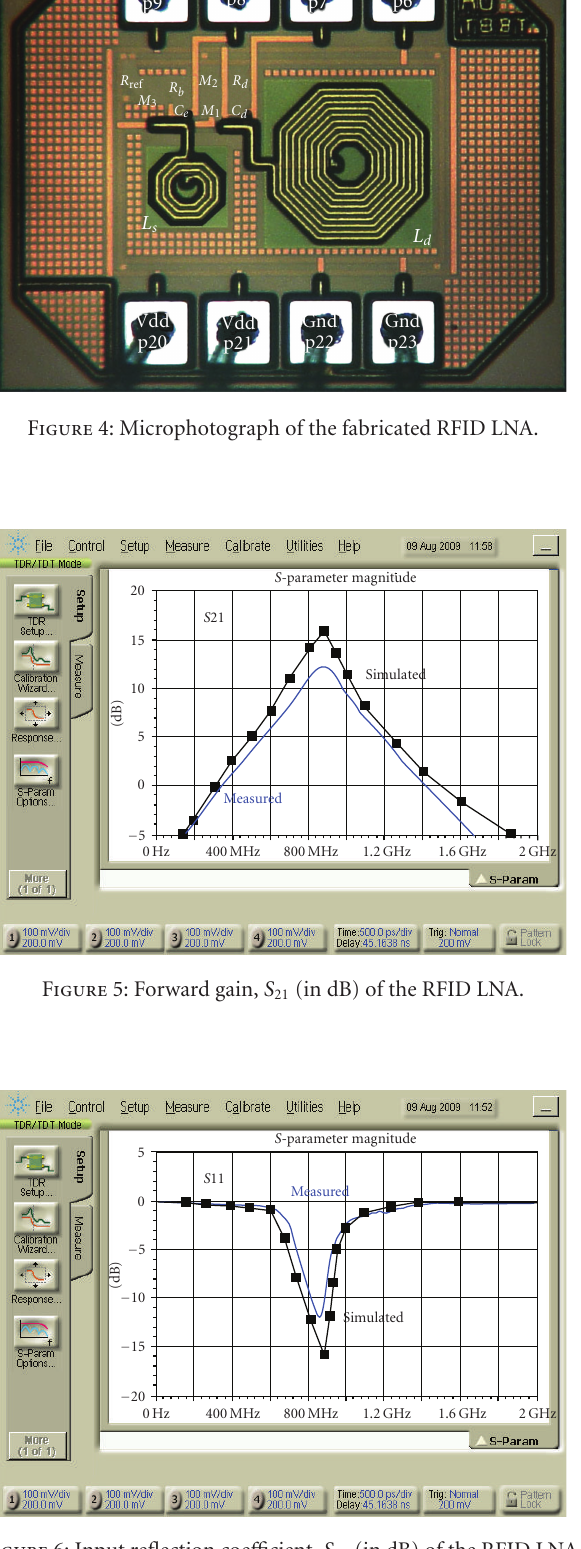
Figure 6: Input reflection coe ffi cient, S 21 (in dB) of the RFID LNA .